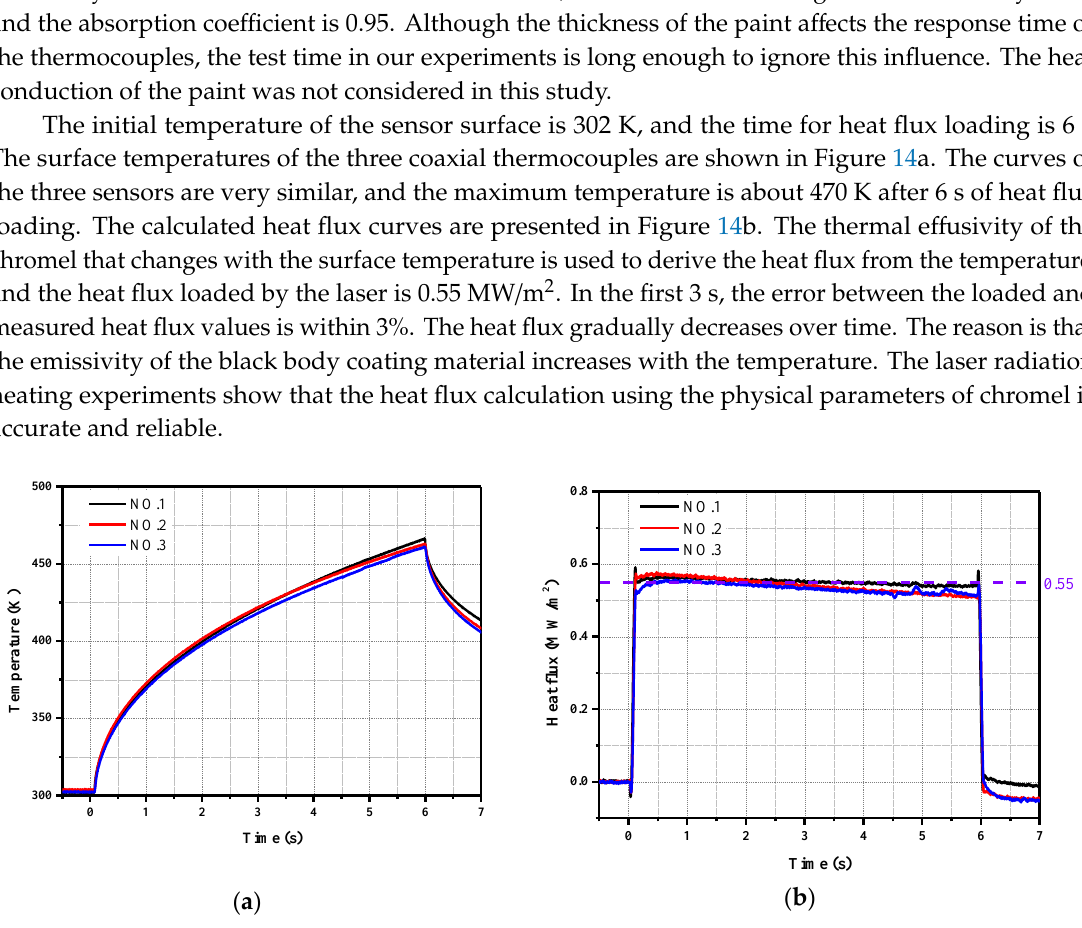
Figure 14. Results of the coaxial thermocouple in the laser radiation heating experiment. ( a ) Surface temperature; ( b ) Heat flux.